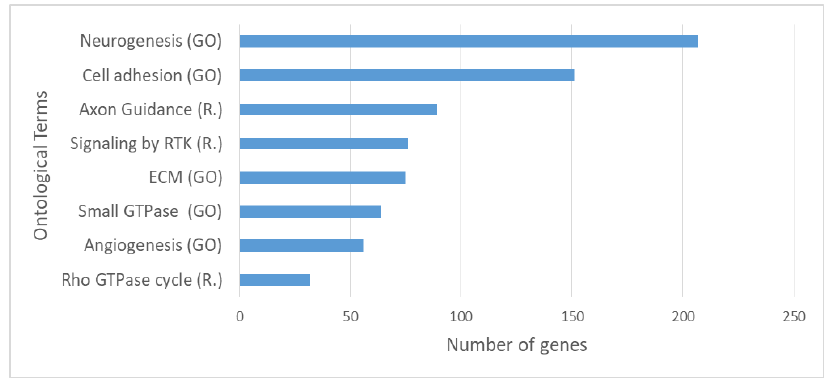
Figure 5. Top significantly enriched Gene Ontology (GO) and Reactome (R.) terms based on enrichment analysis on the 1297 prioritised genes carrying somatic variants with possible functional impact. RTK: Receptor Tyrosine Kinase, “Small GTPase” refers to the term: Signal transduction mediated by Small GTPase.